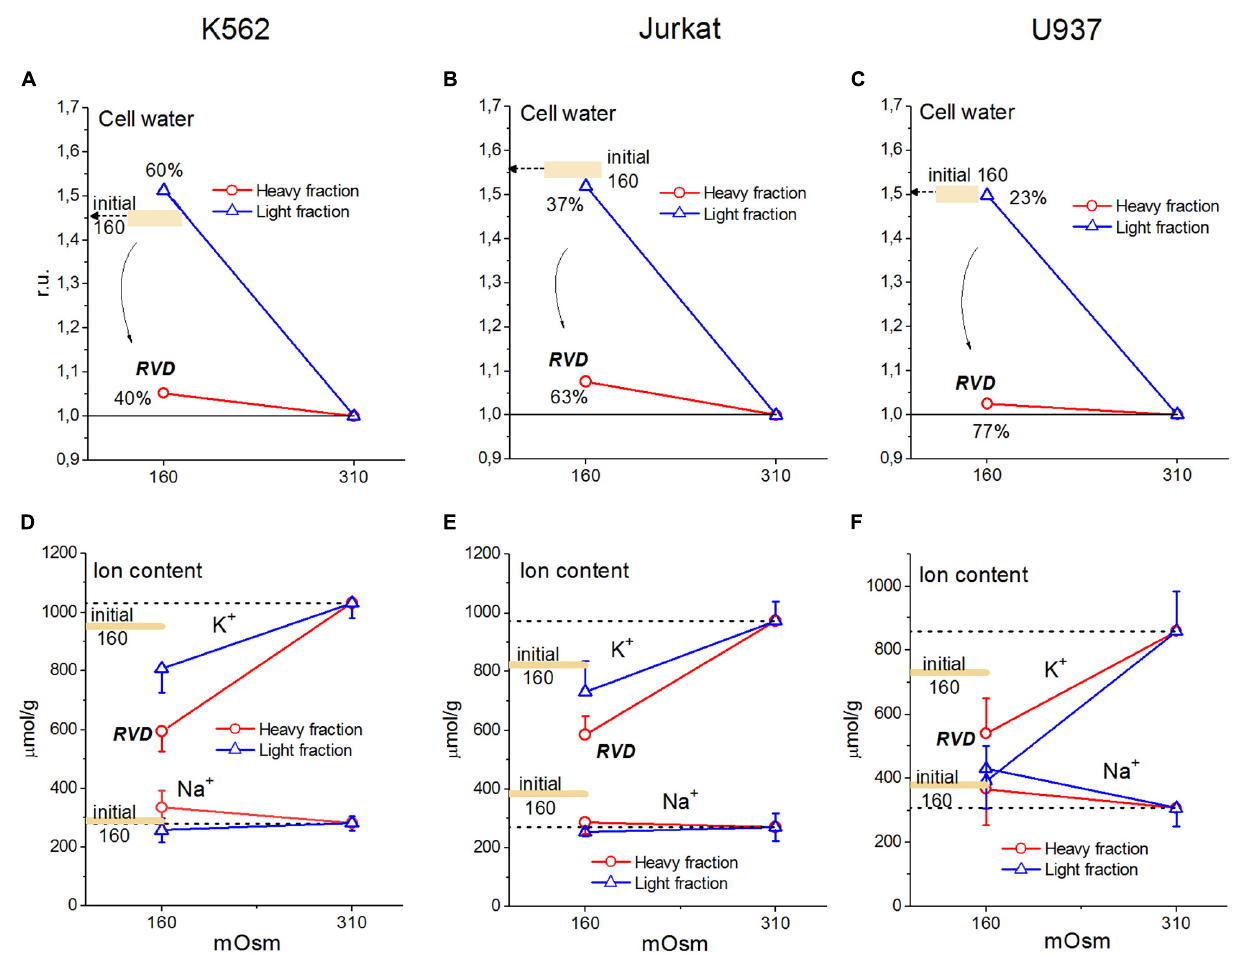
FIGURE 10 | Changes in water, K + and Na + content in K562, Jurkat, and U937 cells after 30 min or 4 h incubation in hypoosmolar medium obtained by a 75 mM NaCl reduction in standard RPMI medium. Means ± SE for at least 3 independent experiments are shown, small SE values are masked by symbols. The broad colored lines show the level of the initial values for 30 min incubation in a hypoosmolar medium. (A–C) The water content in ml/g protein, obtained by measuring the cell buoyant density, is given relative to cell water in a standard RPMI